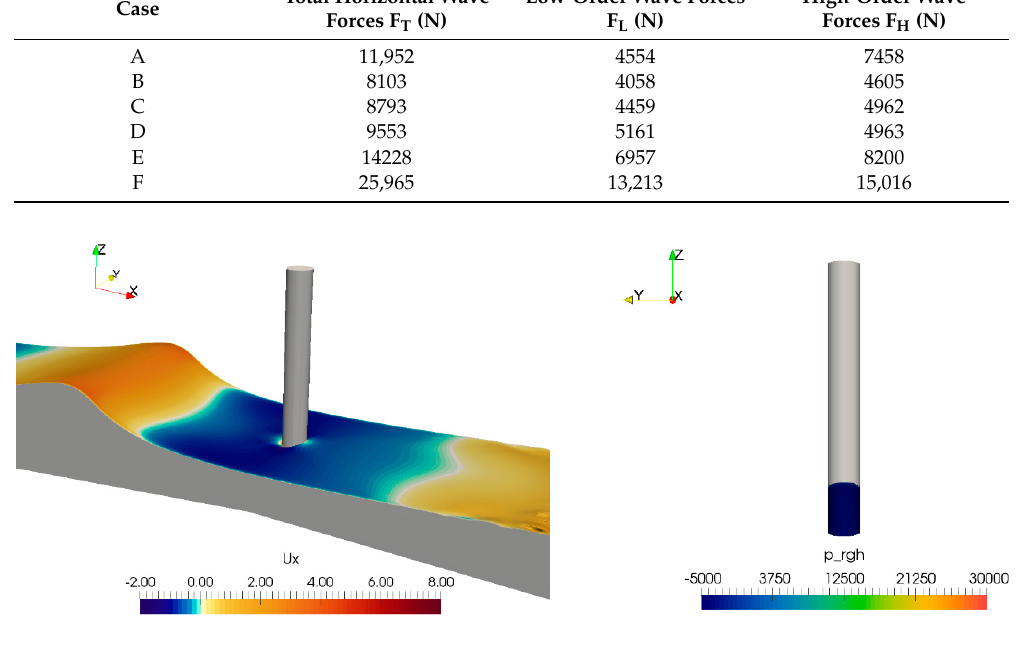
Figure 14. Comparison of the maximum normalized wave forces with transverse inclined angles θ .